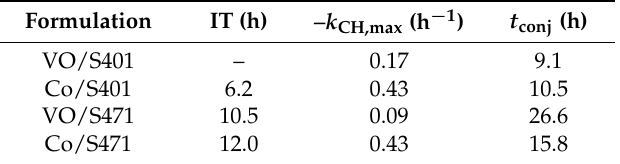
Table 2. Kinetic data of the autoxidation process at metal concentration 0.03 wt